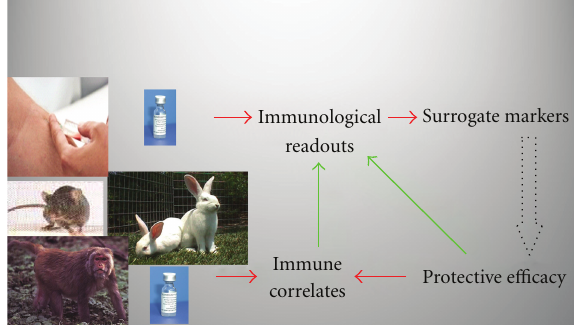
Figure 1: Integrating immunological readouts from nonclinical and clinical studies to identify surrogate markers of e ffi